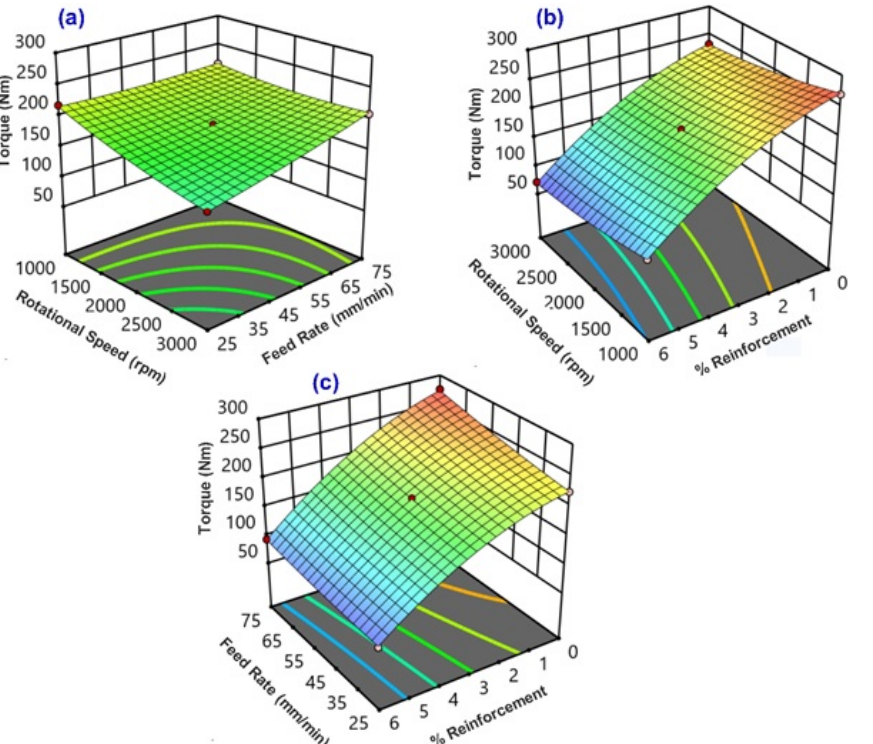
Figure 13. Response surface plot for torque ( a ) rotational speed, feed rate vs. torque ( b ) rotational speed, % reinforcement of mica vs. torque and ( c ) feed rate, % reinforcement of mica vs. torque.